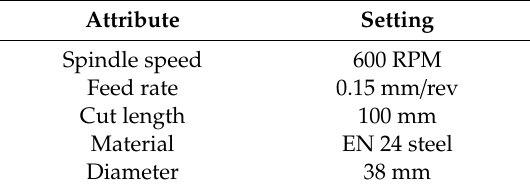
Figure 10. Schema of the experimental configuration showing the key components of a lathe, and the accelerometer mounting positions for the condition monitoring investigation into the effects of cutting depth and tool wear. Table 2. CNC lathe settings used in the experimental condition monitoring experiments.